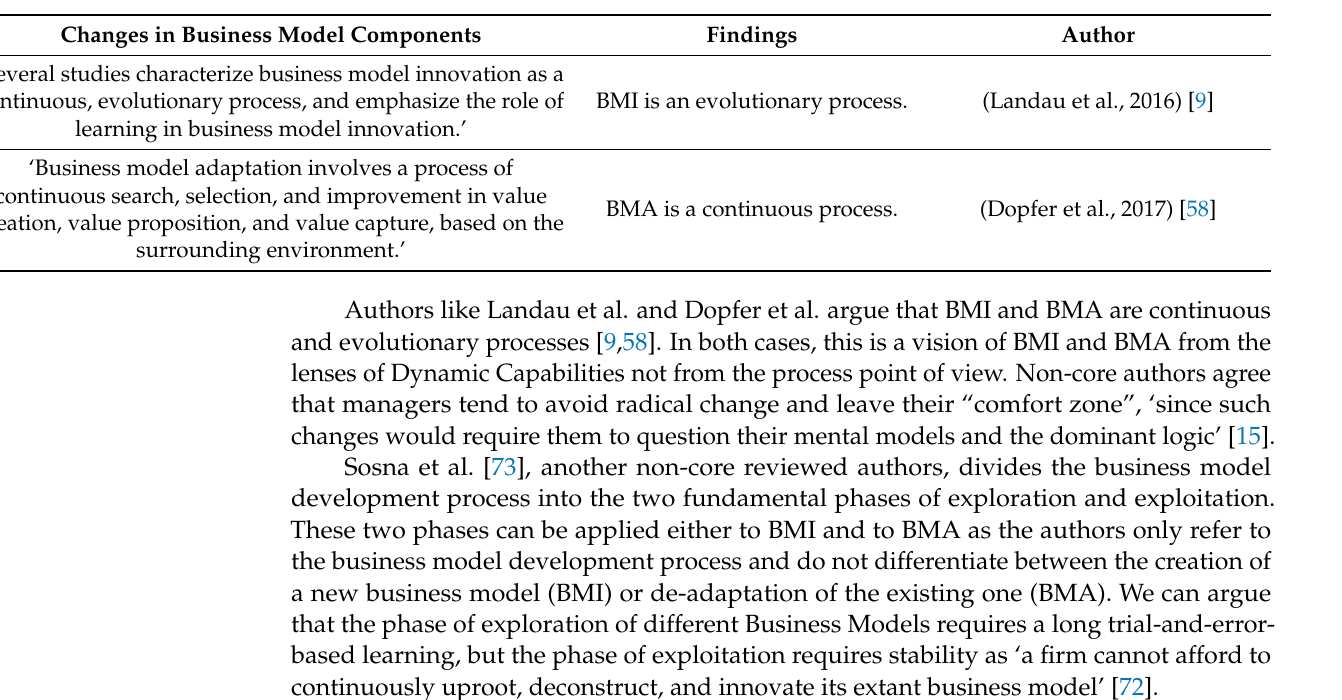
Table 10. Frequency of the processes of BMI, BMA, and